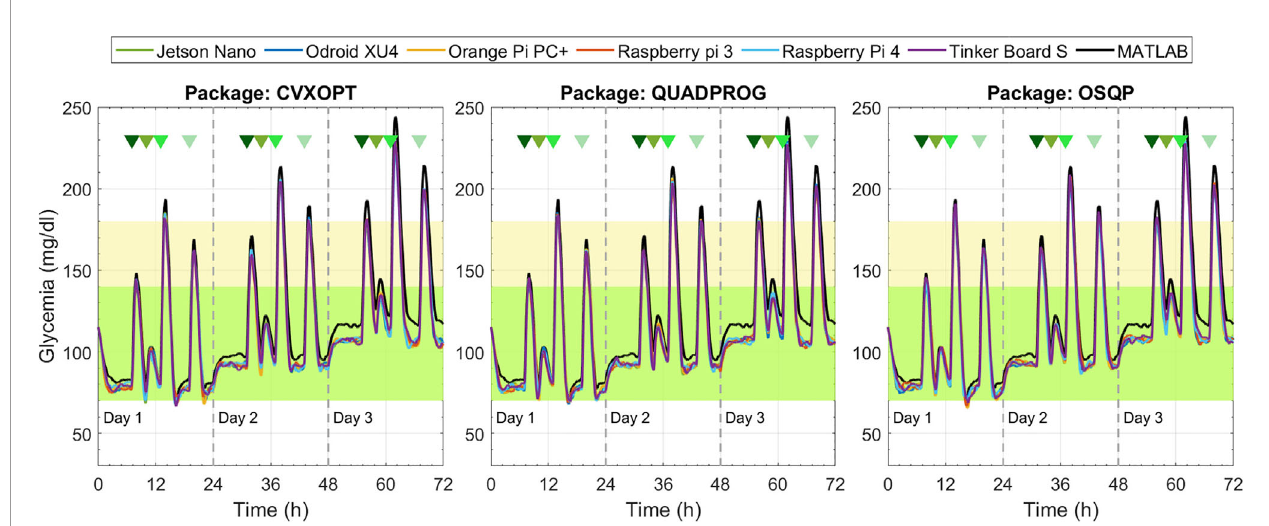
FIGURE 5 | Glycemia evolution under the sMPC strategy with the three solver